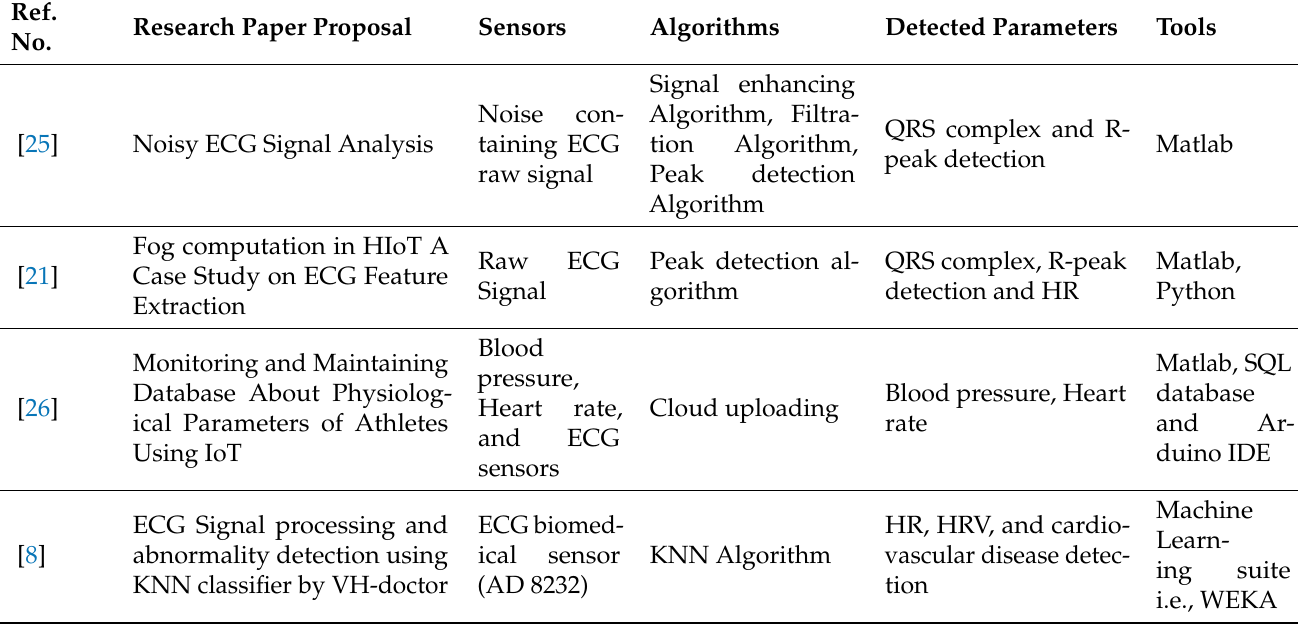
Table 2. Related work about sensors for physiological parameter extraction and processing.